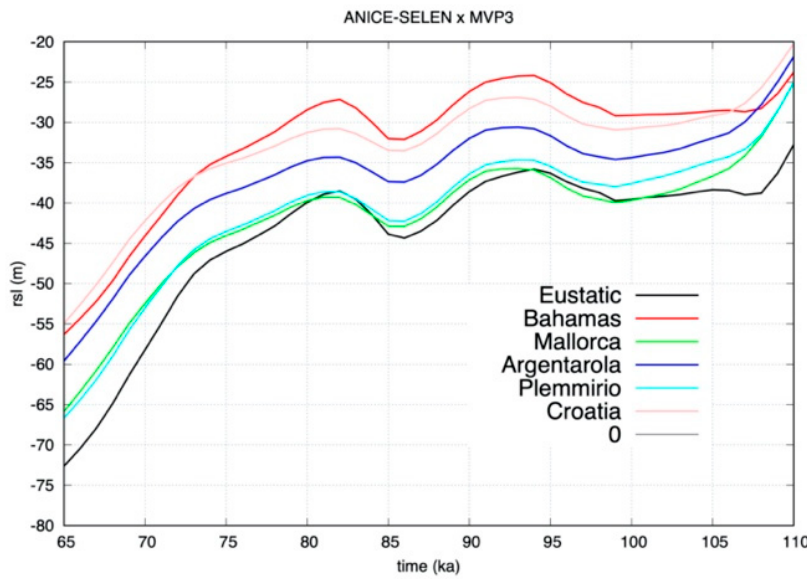
Figure 11. Predicted MIS 5.1–5.3 RSL curves for the Bahamas and at the relevant Mediterranean sites for ANICE-SELEN and the MVP 3 mantle viscosity profile. The black curve shows the eustatic.